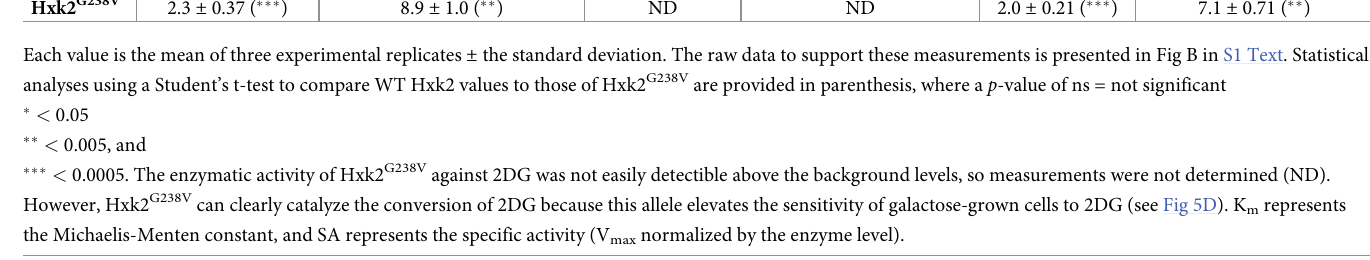
Fig 5. Hxk2 G238V has diminished enzymatic activity against glucose and 2DG. (A) Measure of NADPH production (a proxy for hexose phosphorylation) over time using 5 μ g of yeast total protein extracts made from hxk1 Δ hxk2 Δ glk1 Δ cells containing the plasmids indicated. Use of the empty vector serves as a negative control and demonstrates the specificity of this approach for the activity of the plasmid-borne Hxk2. (B-C) Rate of NADPH production in cells expressing WT Hxk2 (B) or Hxk2 G238V (C) when total protein extracts were incubated with glucose (yellow) or 2DG (blue). In panel B, 0.68 μ g of yeast extract was used (0.032 au per reaction). In panel C, 5.2 μ g of yeast extract was used (0.31 au per reaction) to allow the reduced activity of Hxk2 G238V to be detectable in our assays. Even with the elevated amount of enzyme used, the rate of NADPH production in Hxk2 G238V expressing extracts incubated with 2DG was too low to be accurately measured; the values provided are marked with � to indicate that they are not reliable measures above background. (D) Cells lacking endogenous hexokinase activity ( hxk1 Δ hxk2 Δ glk1 Δ ) but containing an empty vector or plasmid expressing Hxk2 or Hxk2 G238V were grown in galactose and varying concentrations of 2DG. Hxk2 G238V -expressing cells are more sensitive to 2DG than those lacking any Hxk2 activity at all, suggesting that Hxk2 G238V can phosphorylate 2DG in vivo .